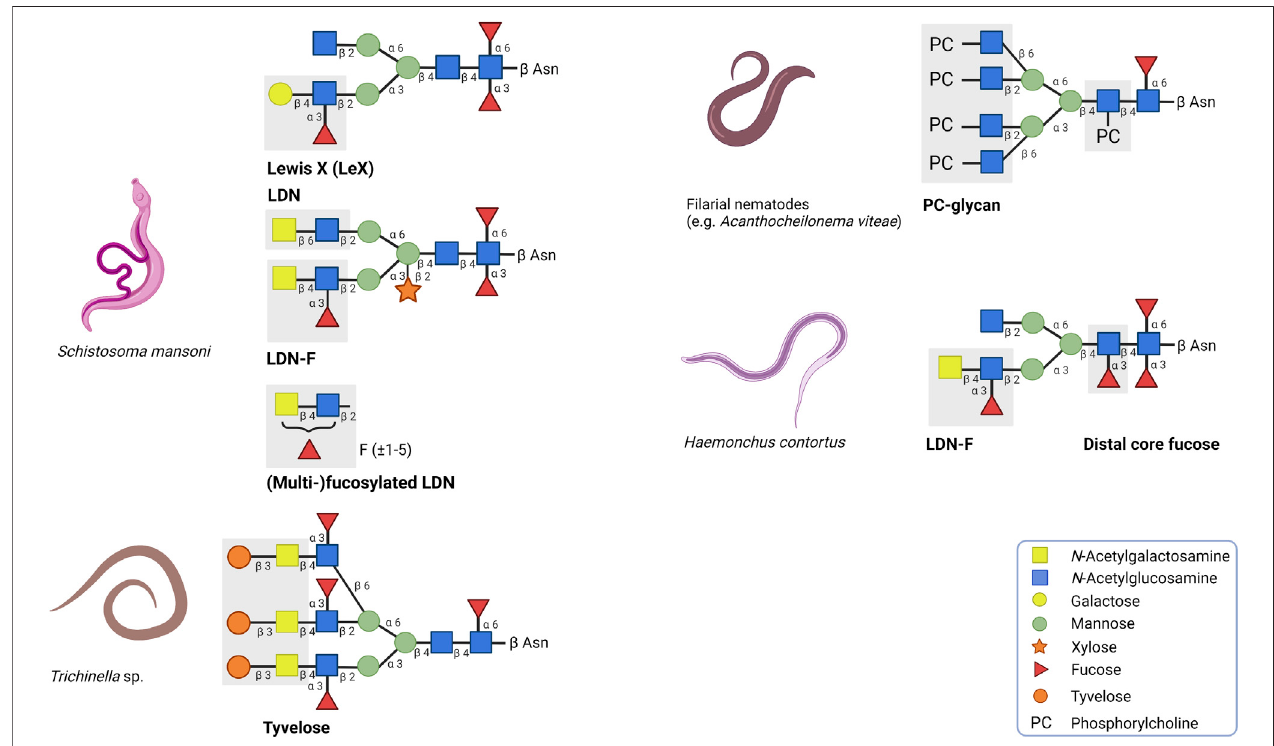
FIGURE 1 | Overview of a selection of helminth glycans with strong immunogenic or immunomodulatory properties. The corresponding positions and symbols of the monosaccharide units are indicated. LDN and (multi)-fucosylated LDN found on secreted egg antigens of the trematode Schistosoma mansoni are associated with immunogenicresponseswhereas LewisXhasimmunomodulatoryeffects.Incontrasttotheotherglycanmotifs,multi-fucosylated LDNisfoundonO-glycans.Tyvelose expressed by Trichinella species and distal core fucose expressed by Haemonchus contortus are glycan motifs which are associated to be important to induce humoral immunity. Glycoproteins carrying phosphorylcholine (PC) are mainly secreted by fi larial nematodes and in many cases, PC is responsible for the immunomodulatory effects of these